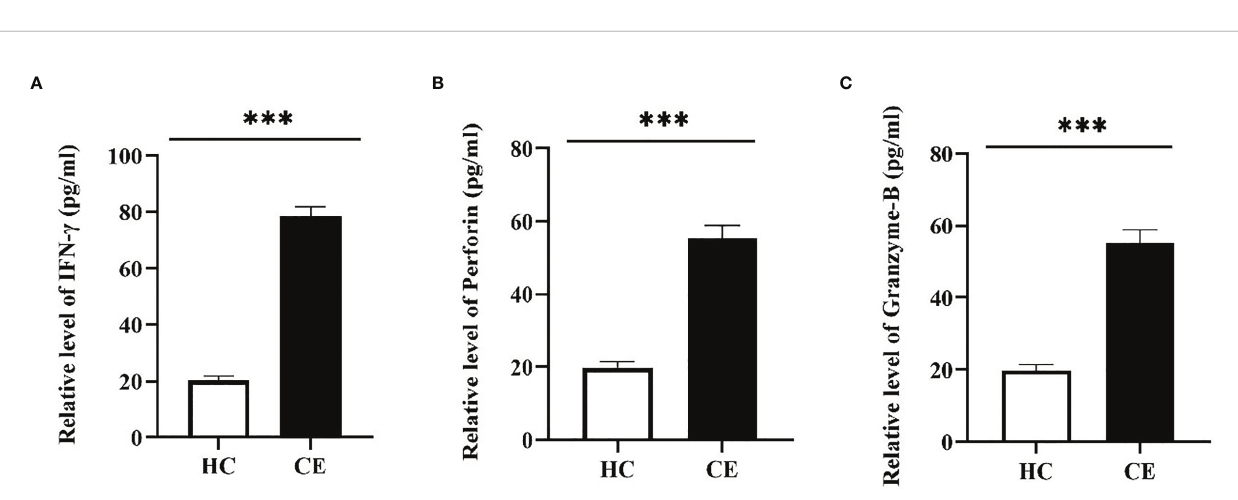
structure is composed of Beta turn and Random coil that mainly located in the external regions, it is easier to be identi fi ed and combined by the leukomonocytes and antibody (27).